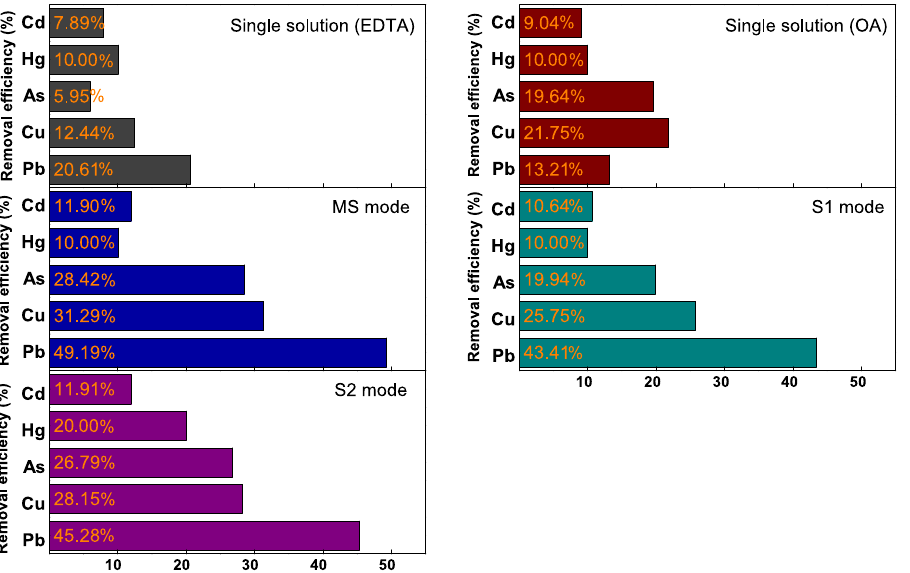
Figure 3. Comparison of the efficiencies of the different heavy metal removal methods.